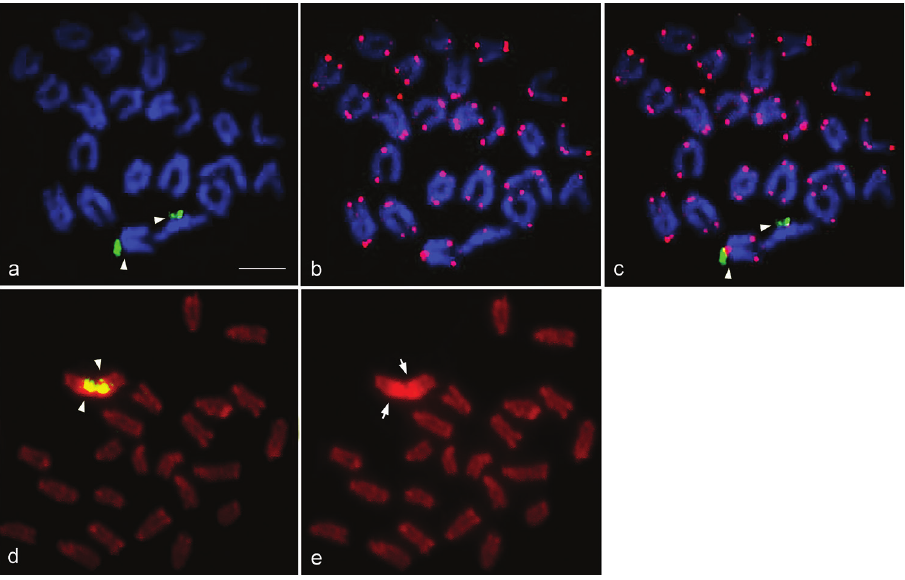
Figure 2. Chromosomal locations of the 18S – 28S rRNA genes and (TTAGGG)n sequences in Monop- terus albus . Hybridization pattern of FITC-labeled 18S – 28S rRNA genes (green) ( a ) and rhodamine-la- beled TTAGGG repeats (red) ( b ) on DAPI-stained chromosomes, and their co-hybridization pattern ( c ). Hybridization pattern of FITC-labeled 18S – 28S rRNA genes (green) ( d ) on PI-stained chromosomes. PI-stained patterns of the same metaphase spreads of ( d ) is shown in ( e ). Arrowheads indicate FISH sig- nals of the 18S – 28S rRNA genes. Arrows indicate the large PI-stained region. Scale =10